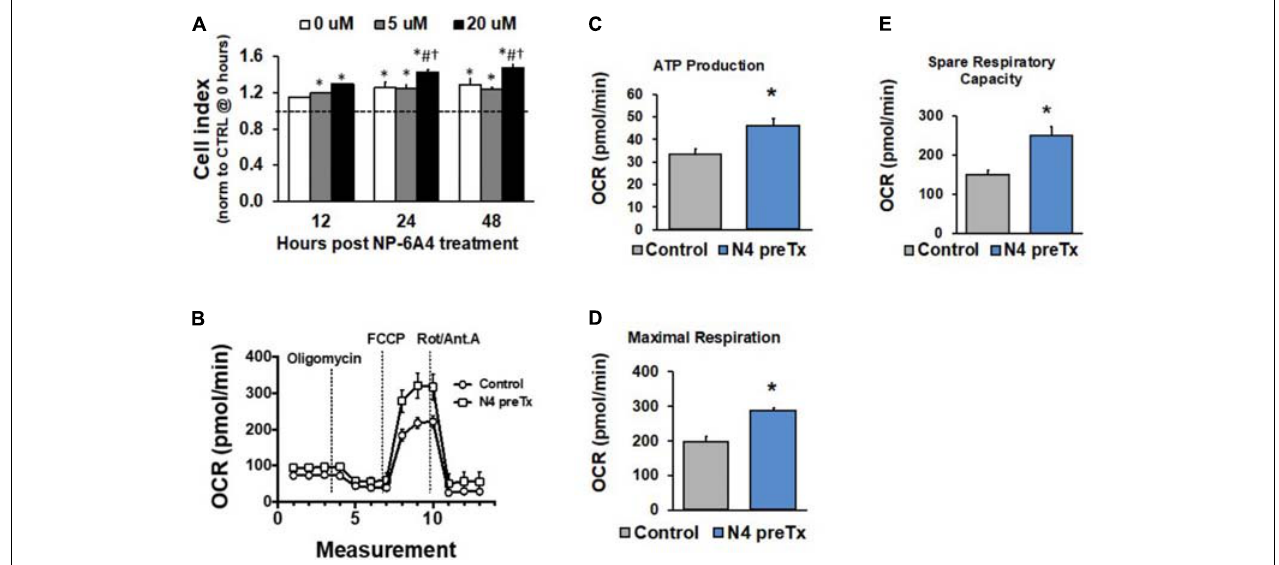
FIGURE 4 | NP-6A4 increased hCAVSMC growth properties and mitochondrial energetics. (A) Cell Index in cells pretreated with NP-6A4 for 7-days and then treated with increasing doses of acute NP-6A4 from 0 to 20 µ M. All doses increased CI compared to untreated (CTRL) cells. Data were analyzed using a two-way ANOVA with dose and time serving as independent variables. ∗ indicates p < 0.05 vs. CTRL cells at baseline. # Indicates p < 0.05 vs. 0 µ M at same time point. † Indicates p < 0.05 vs. 5 µ M at the same time point. n = 4 per group. (B) OCR increased after 7-days of 1 µ M NP-6A4 treatment measured using the Seahorse Extracellular Flux Assay. (C) ATP production was increased after NP-6A4 treatment. (D) Maximal respiration was increased after NP-6A4 treatment. (E) Spare respiratory capacity was increased after NP-6A4 treatment. n = 3 per group. ∗ Indicates p < 0.05 using One-way ANOVA. hCAVSMC, human coronary artery vascular smooth muscle cell.